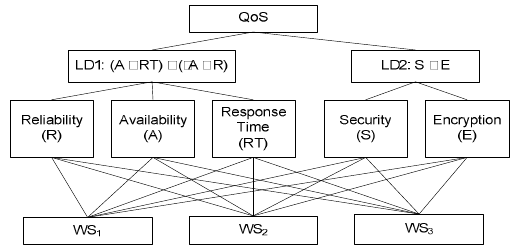
Fig. 2. Hierarchical model for web service selection when both the goal and the criteria are logical